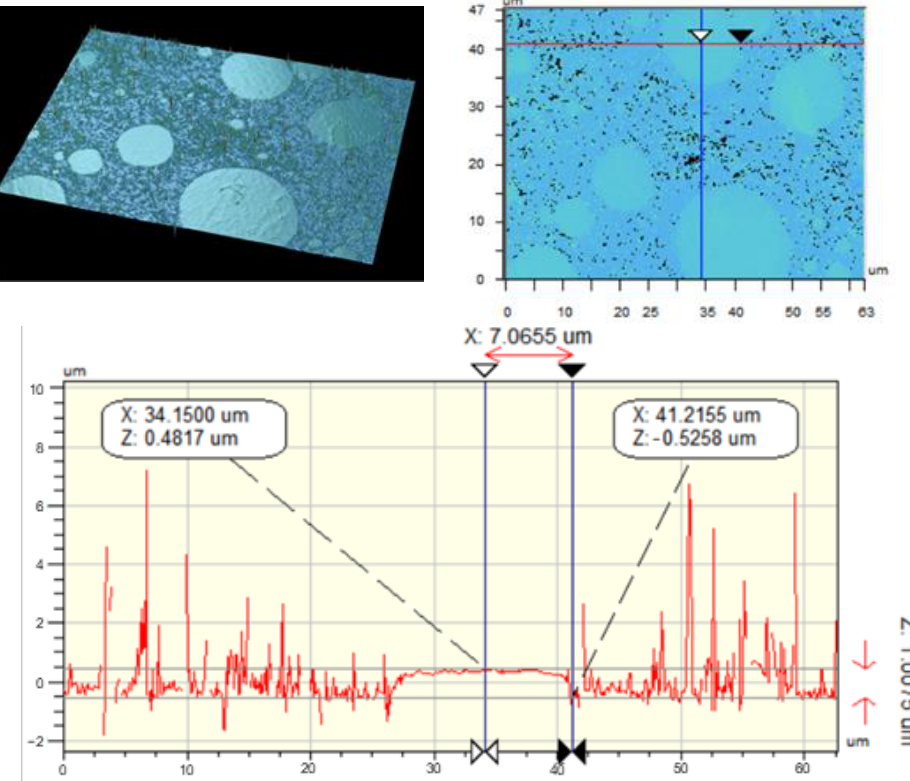
Figure 7. Results of the vertical scanning interferometry (VSI) - pictures of the surface and height profile of the sample PLA/PE-HD 80/20 E 4000 s + T 30 min.